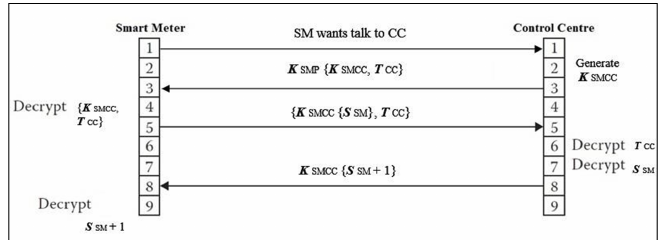
Figure 3. Secure two-way communication by providing an authentication and key session